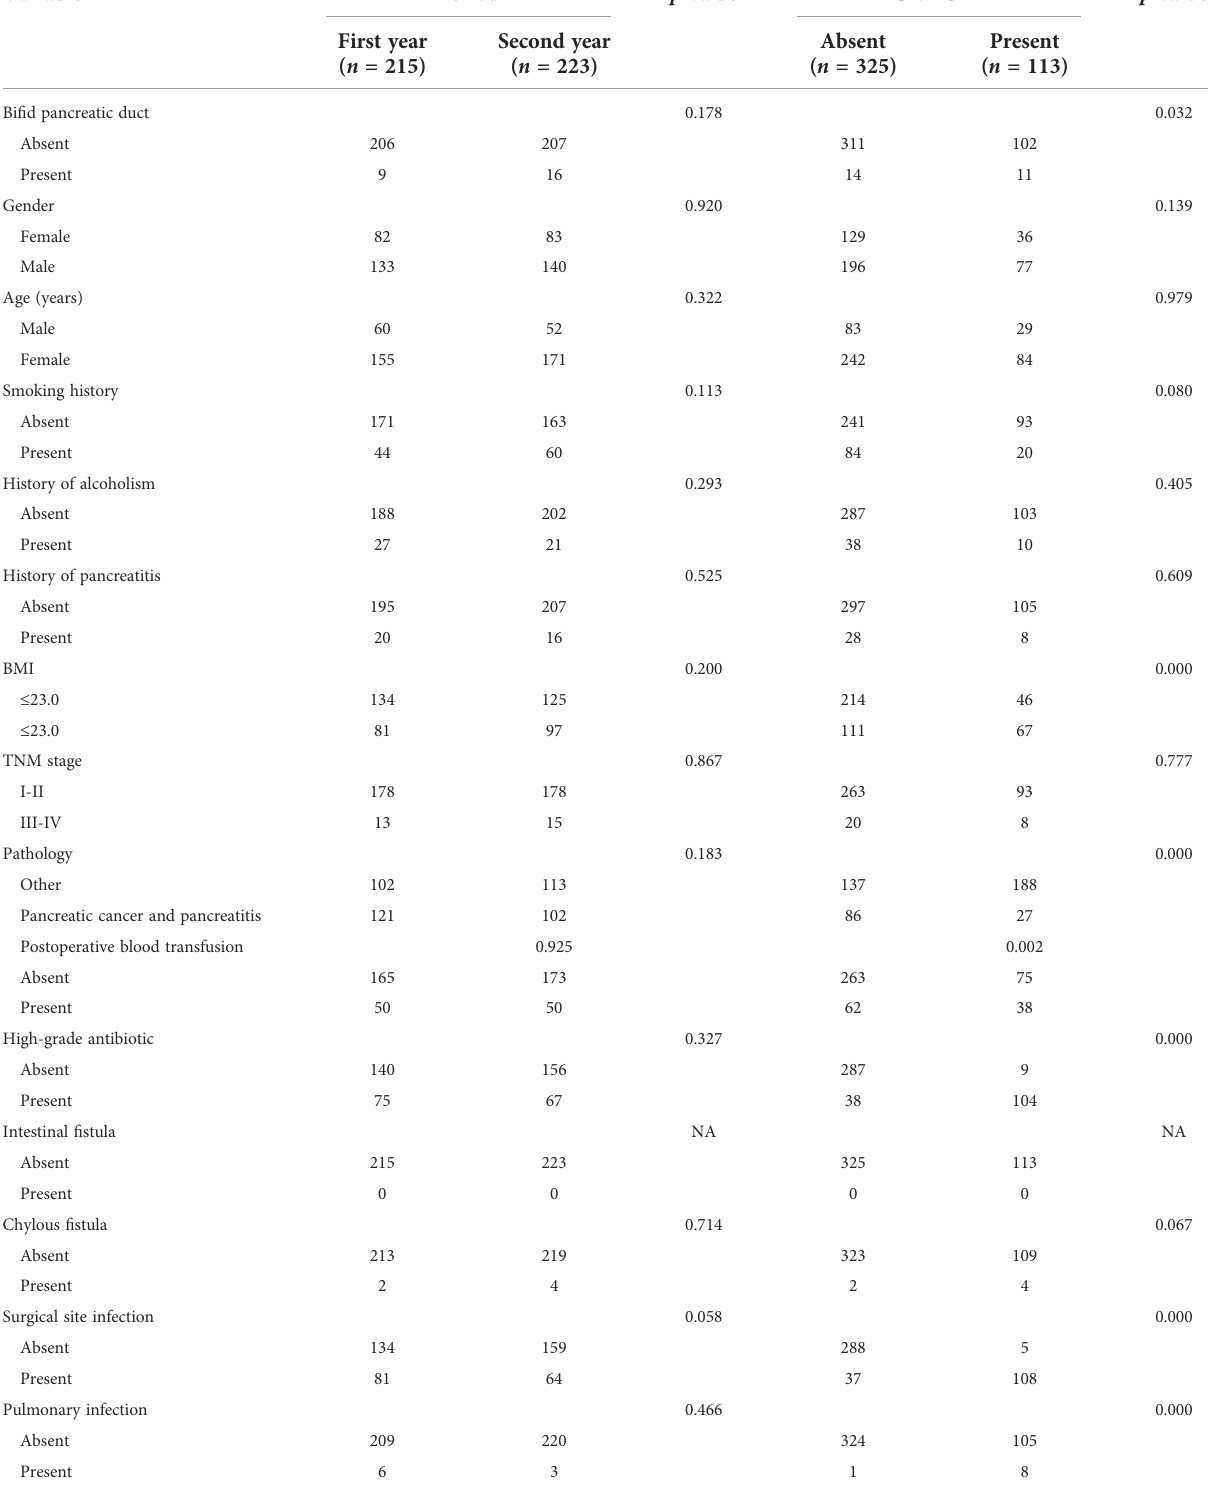
TABLE 1 Clinicopathological characteristics and postoperative